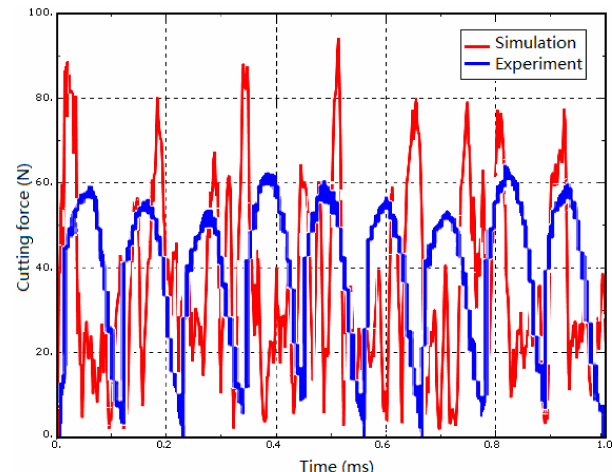
Figure 11. Comparison of primary cutting force between simulation and